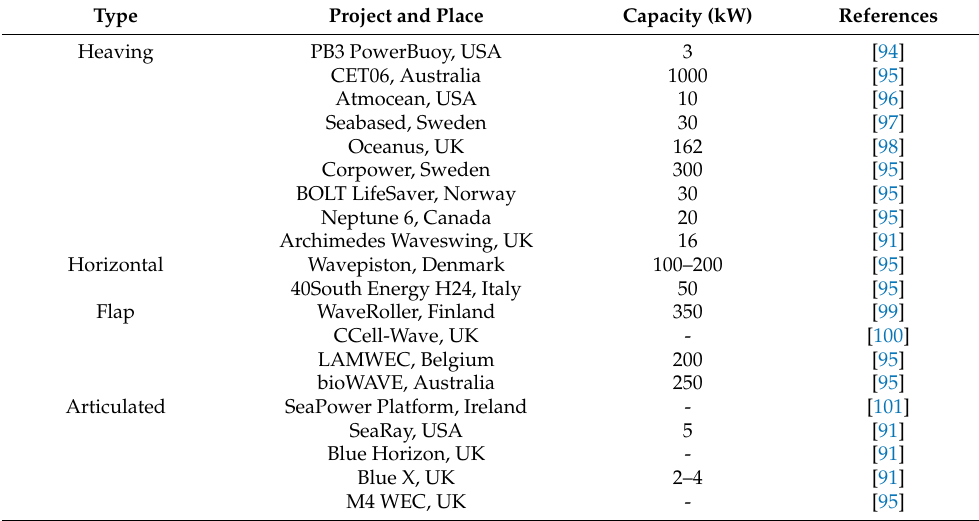
Table 4. Running demonstration projects for the OBC in several